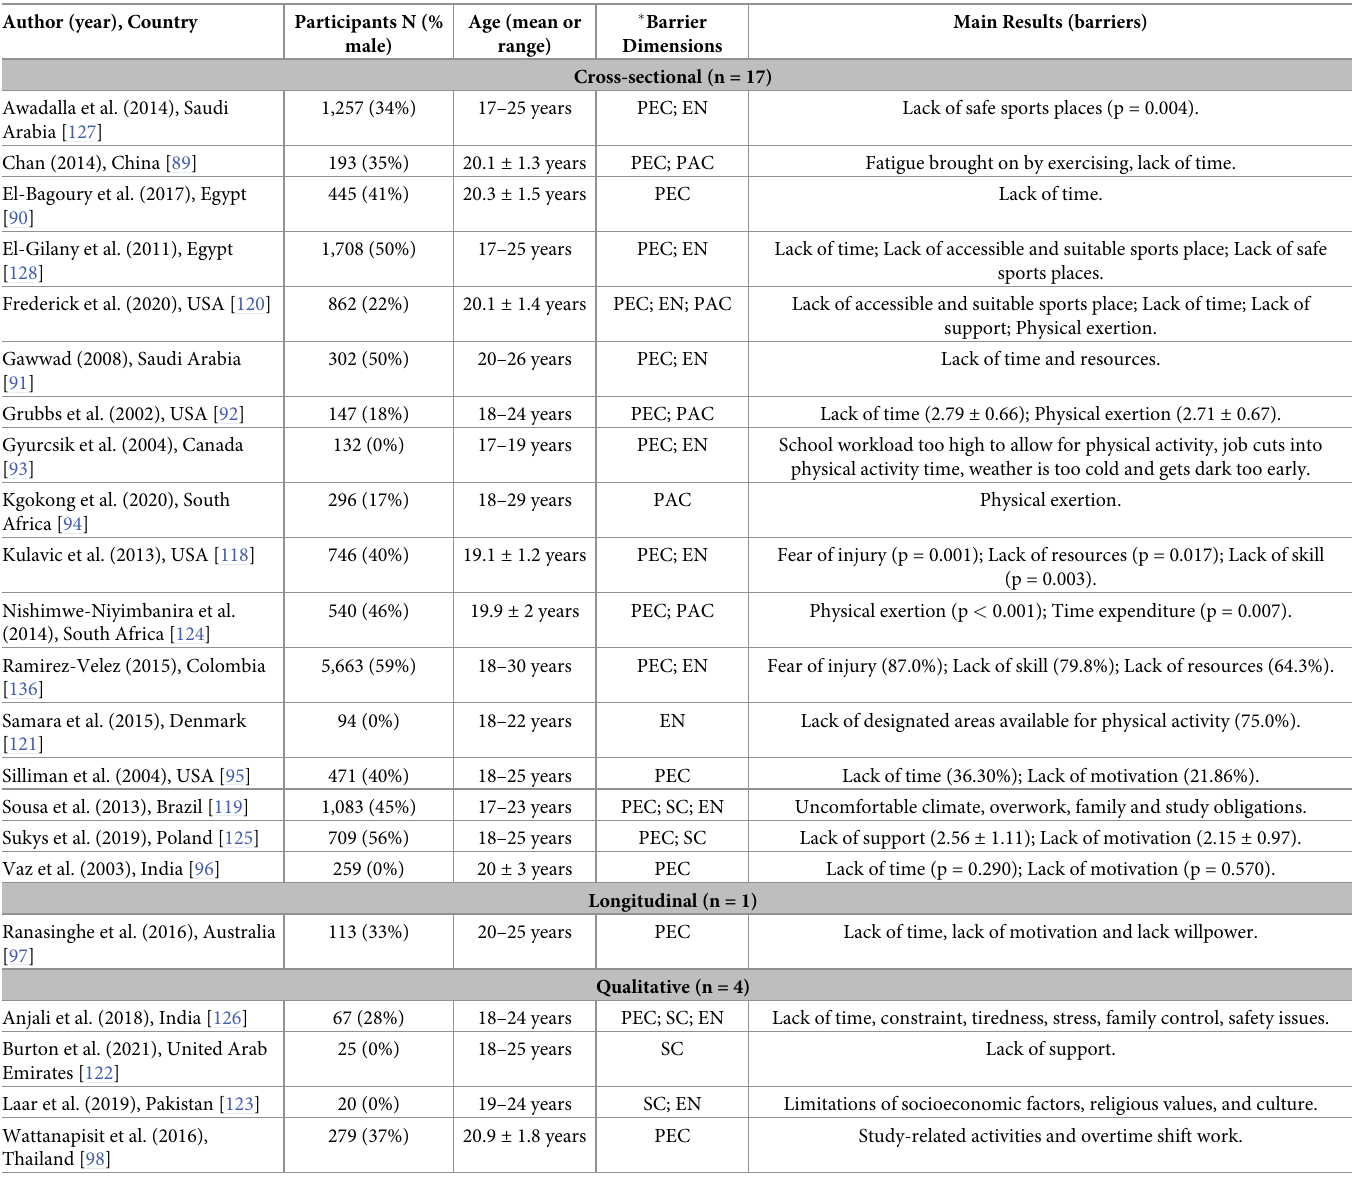
Table 3. Characteristics of the studies examining barriers to physical activity in university